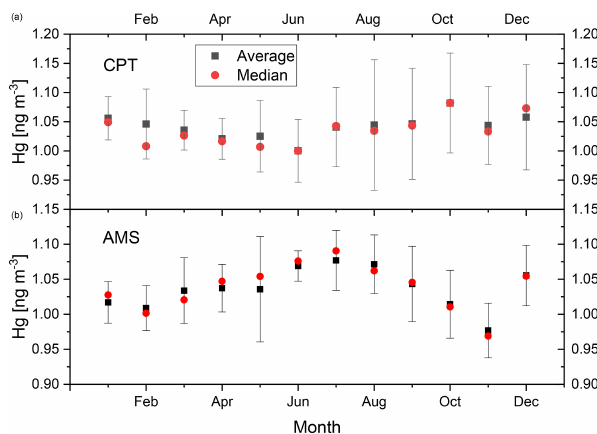
Figure 2. Seasonal variation in GEM in 2012–2017 at CPT (a) and AMS (b) . The points represent averages and medians of monthly medians over the 2012–2017 period. The bars represent the standard deviations of the monthly